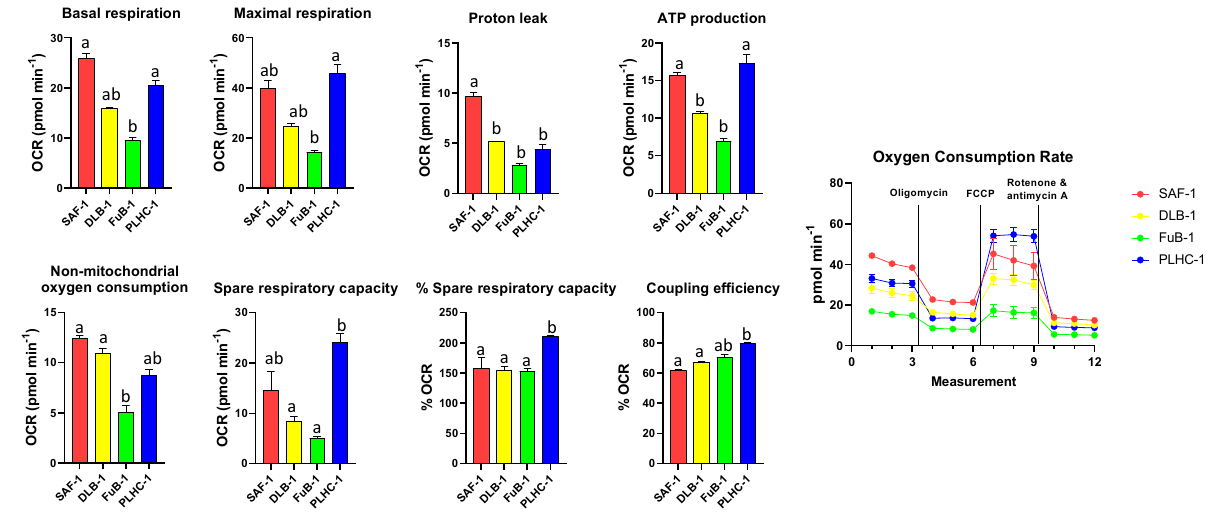
Figure 1. Comparison of cell respiratory capacities between different cell lines (SAF-1, DLB-1, FuB-1, and PLHC-1). Oxygen consumption rates (OCR) were measured following overnight cell proliferation. The Mito Stress Test was conducted following the injection of the test drug, which consisted of the sequential additions of oligomycin (1.5 µ M), FCCP (0.5 µ M; 2 µ M in the case of PLHC-1), and rotenone + antimycin A (0.5 µ M). The different parameters were calculated using Wave 2.6.3 software and the Seahorse XF Mito Stress Test Report Generator tool, according to the Agilent Technologies procedures. Absolute OCR values are shown (means ± SDs, n = 5 wells). Statistical differences are denoted by different letters ( p < 0.05).